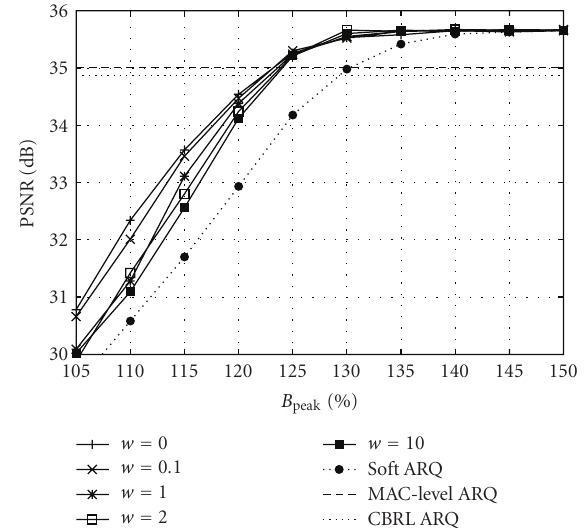
Figure 6: PSNR as a function of the peak bandwidth for the pro- posed ARQ scheme for di ff erent values of the w parameter, com- pared to the Soft ARQ technique and to the best performance of the MAC-level and CBRL ARQ schemes ( paris sequence).